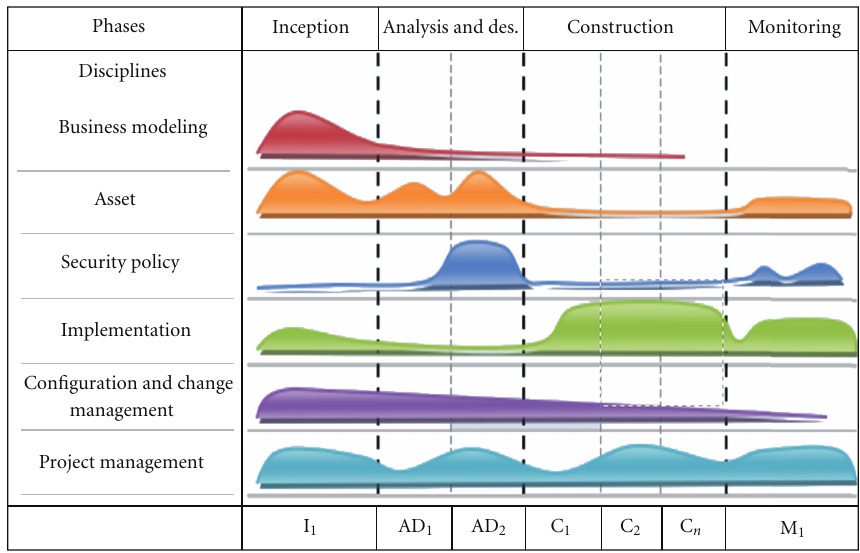
Figure 1: SUP architecture (phases: dynamic dimension; disciplines: static